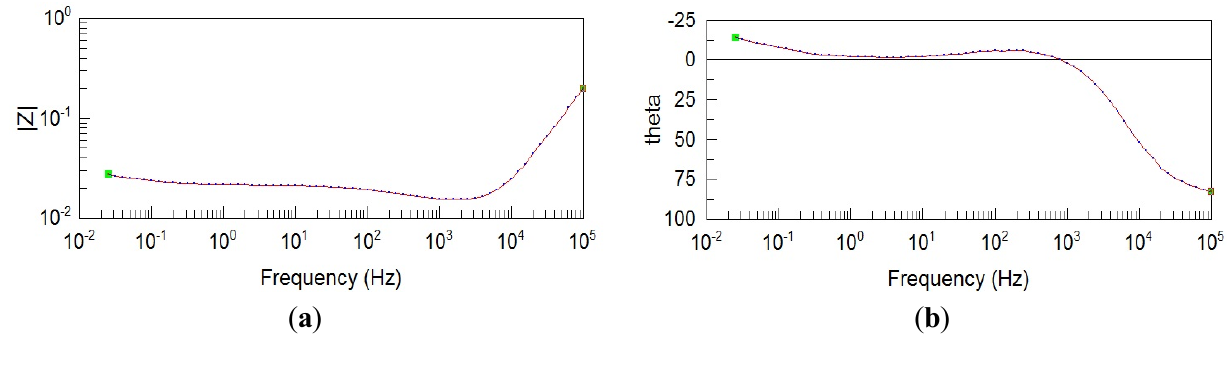
Figure 10. A typical Li-ion test battery AC impedance Bode plots ( a ) The relation between impedance magnitude; and frequency ( b ) The relation between impedance angle and